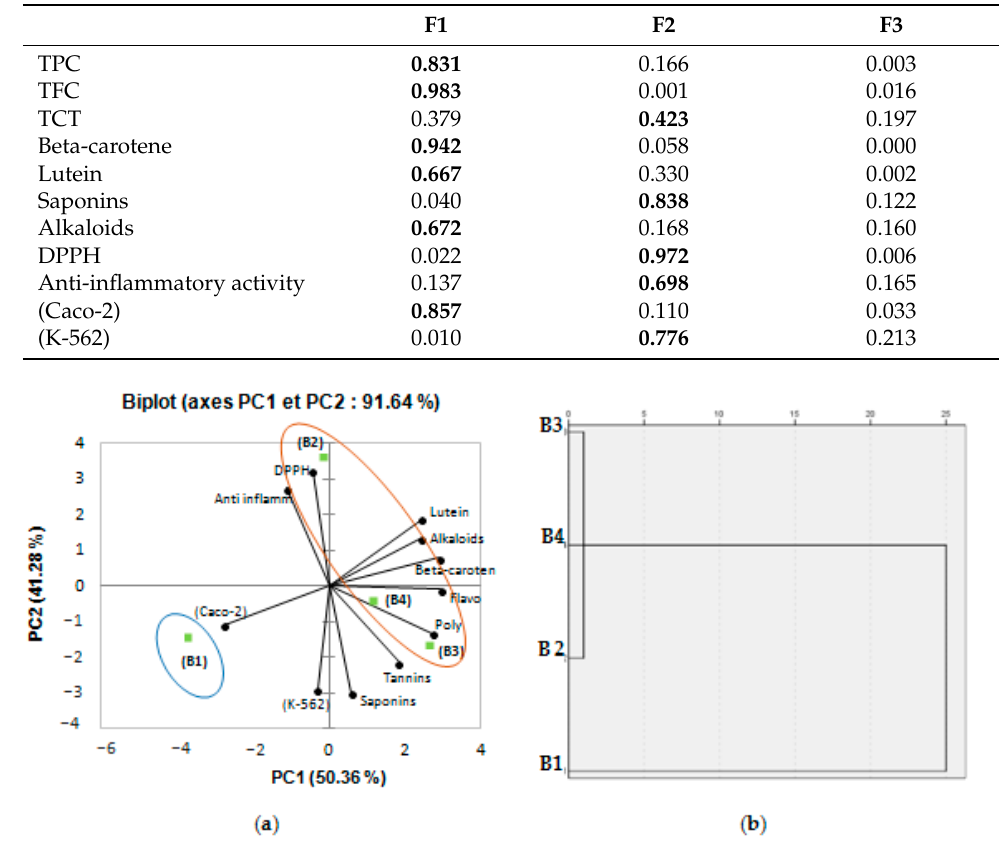
Figure 3. ( a ) Principal components analysis biplot (axes F1 and F2: 91,64%); ( b ) dendrogram comparing measured bioactive components and biological activities of different populations (four geographical localities of B. tournefortii , B1: Sfax; B2: Gabes; B3: Zarzis; B4: Tatouine).